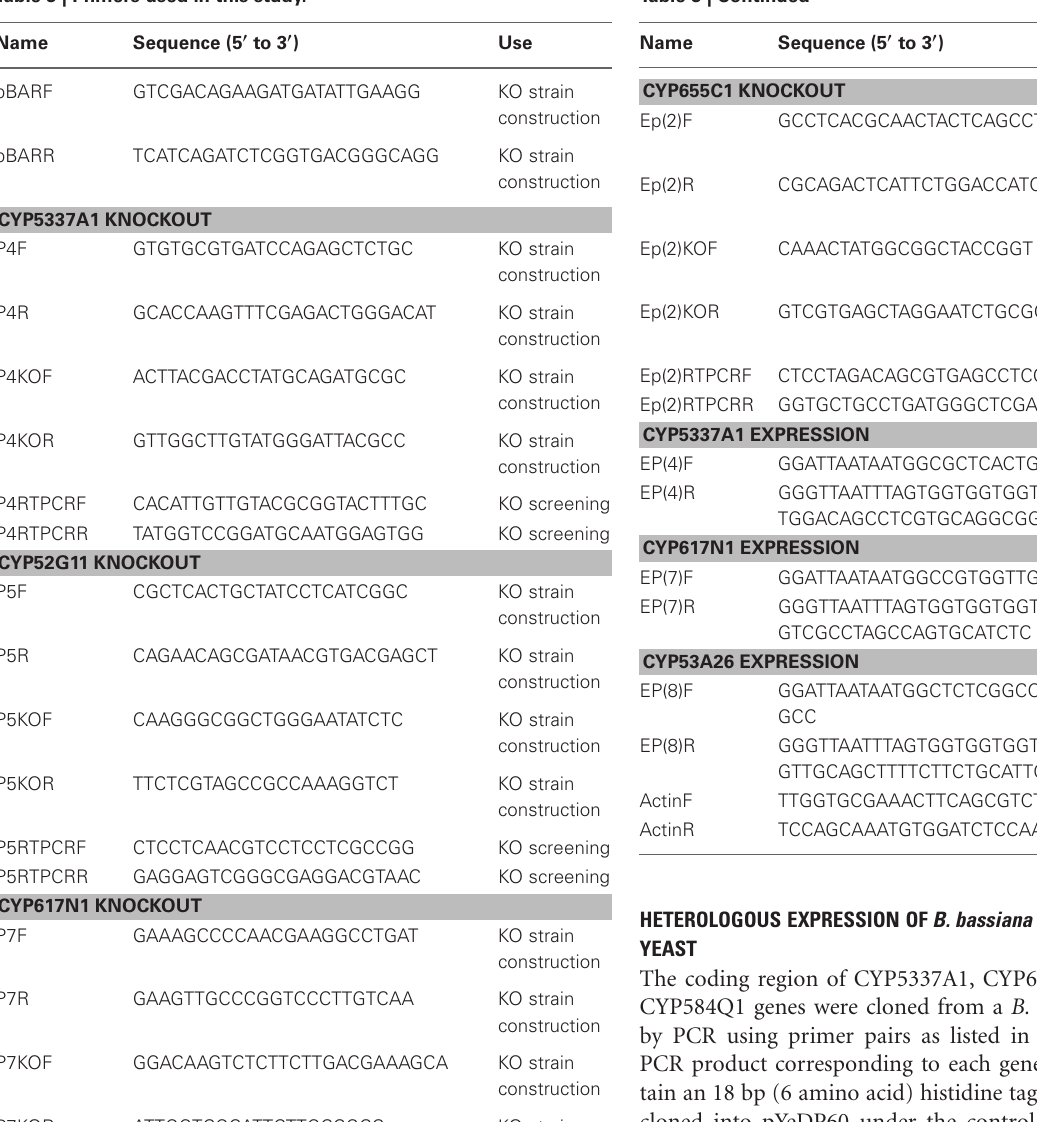
Table 3 | Primers used in this